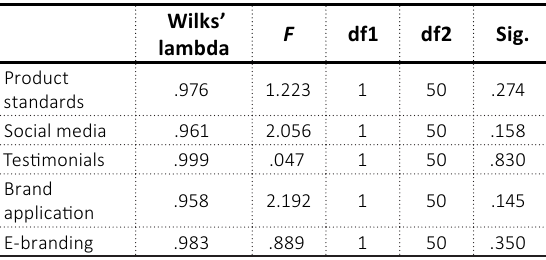
Table 8. Test of equality of means